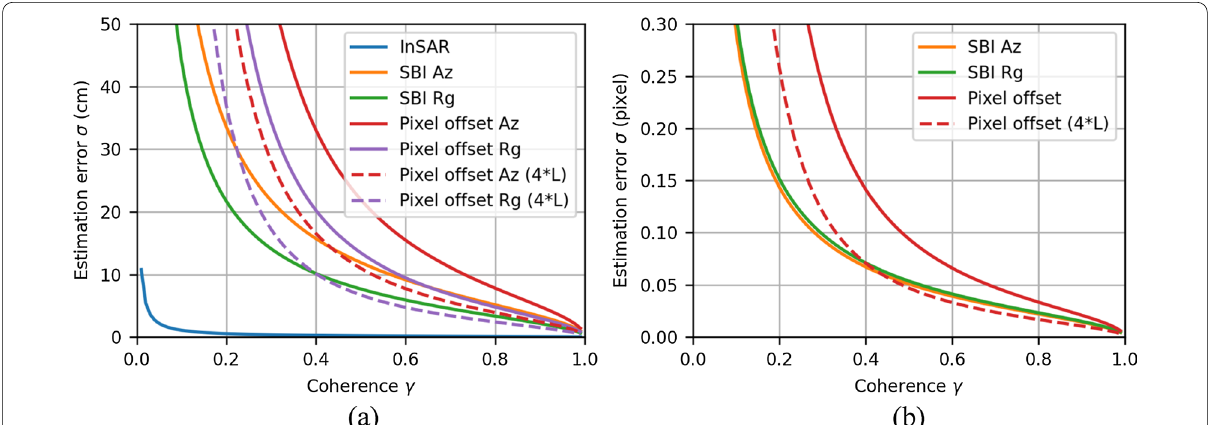
Fig. 1 Dependency of the theoretical error on coherence in InSAR, SBI, and the pixel offset method. The parameters are based on the real data used in this study; ALOS-2, U mode (84 MHz in range), beam number 7, 16 respectively. a Units in cm. b Units in